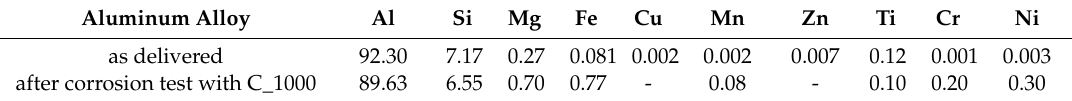
Table 17. Composition of AlSi7Mg0.3 as delivered and after corrosion tests with C_1000 (in wt %). Aluminum Alloy Al Si Mg Fe Cu Mn Zn Ti as delivered 92.30 after corrosion test with C_1000